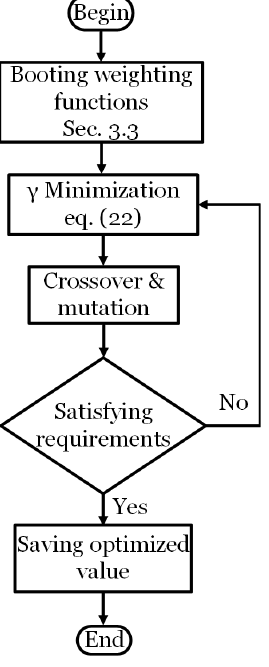
Figure 2. Controller synthesis through genetic